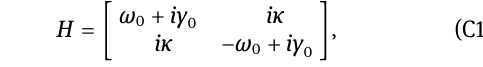
Figure 10: APT-symmetric system side-coupled to a